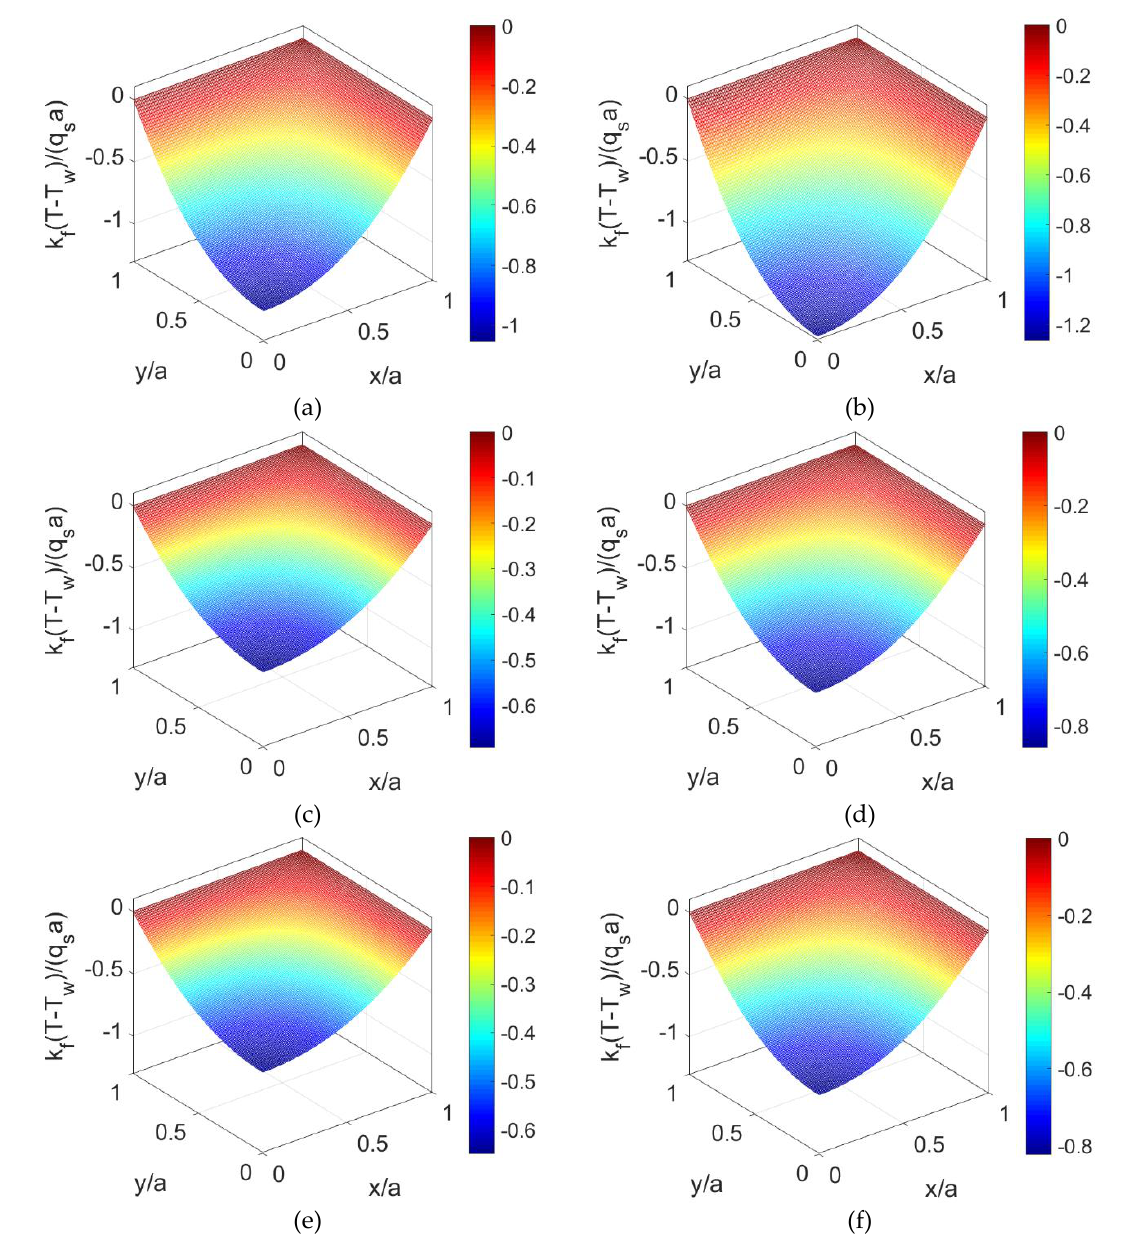
Figure 4. The dimensionless temperature distributions of shear thinning fluid, Newtonian fluid, and shear thickening fluid for di ff erent Joule heating parameter when nanoparticle volume fraction is φ = 0: ( a ) n = 0.8, S = 0; ( b ) n = 0.8, S = 3; ( c ) n = 1.0, S = 0; ( d ) n = 1.0, S = 3; ( e ) n = 1.2, S = 0; ( f ) n = 1.2, S =